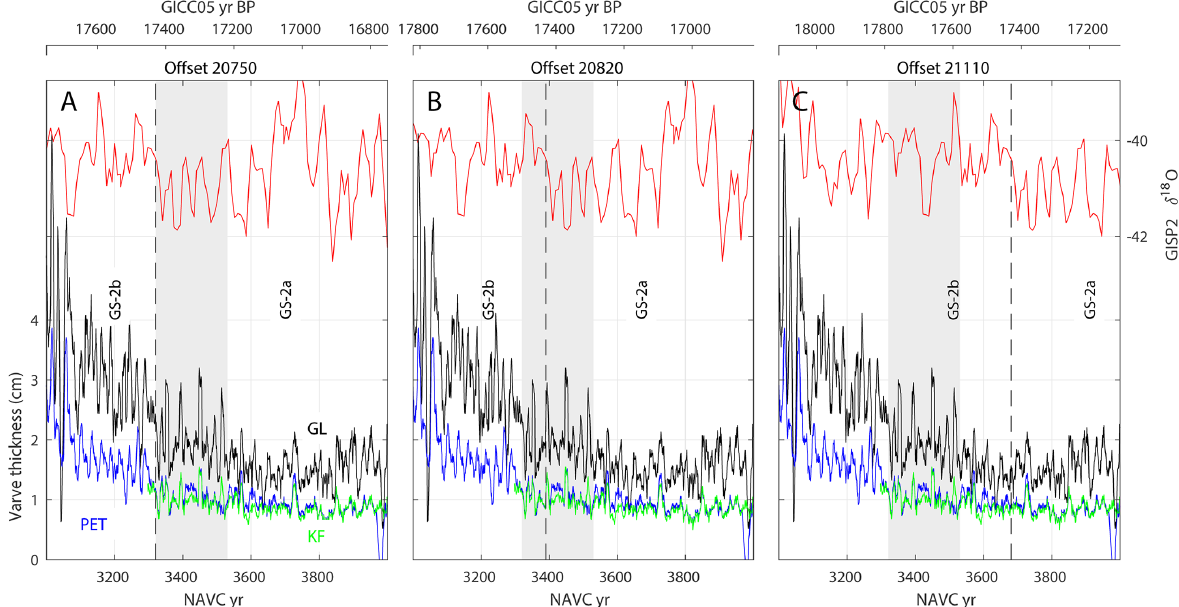
Figure 26. Correlation between NAVC and GISP2 climate proxy records near 17500 GICC05yrBP. This duplicates Fig. 14b of Ridge et al. (2012), except that the x axis is reversed for consistency with the rest of the figures in this paper. The plot elements are the same as in Fig. 24. Varve thickness records shown are from Glastonbury (GL), Kelsey–Ferguson (KF), and South Windsor, CT (PET; see Ridge et al., 2012). The gray band shows the period of the Chicopee Readvance, which is associated with a period of thin varves at NAVC 3320–3530.